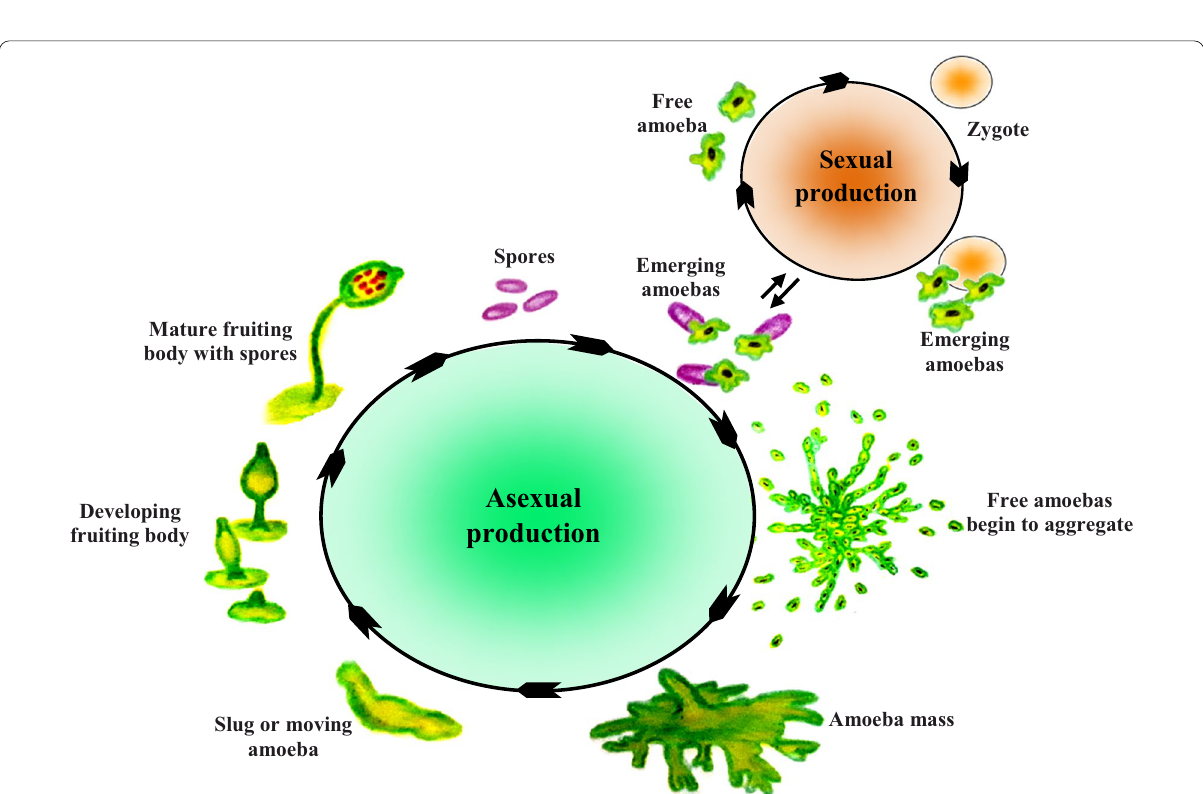
Fig. 3 Life cycle of a cellular slime